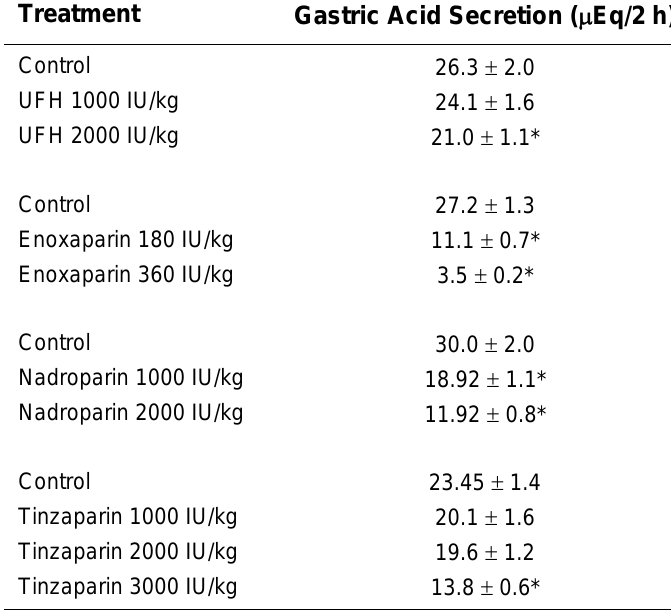
Inhibition of Gastric Acid Secretion Stimulated by Distention by UFH and LMWHs in Urethane-Anesthetized Rats Treatment Gastric Acid Secretion ( μ Eq/2 h)